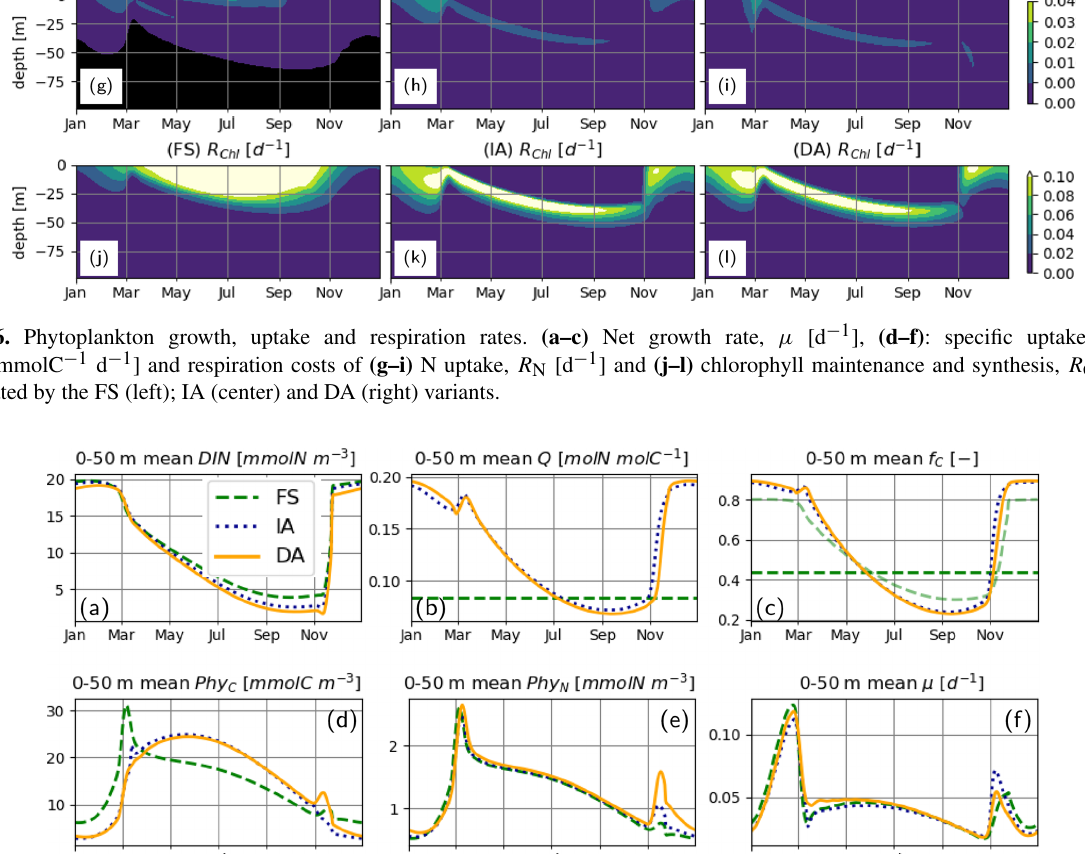
variants are, respectively, 8.1 % and 13.9 % smaller